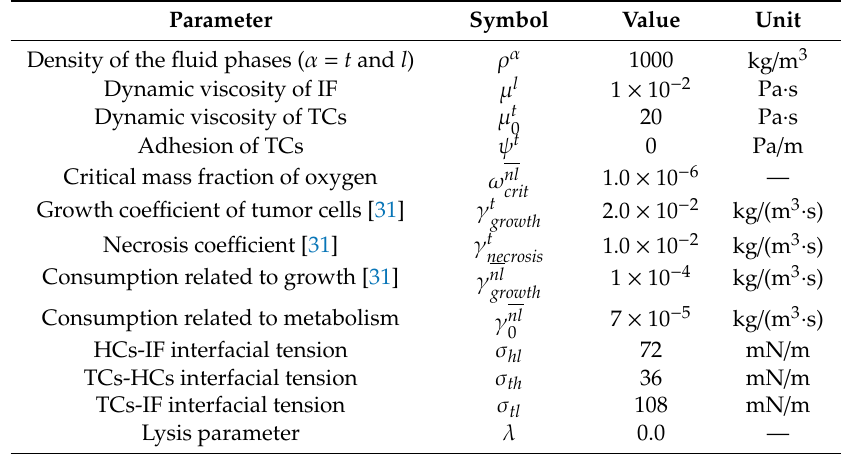
Table 1. Parameters depending on cells’ type and IF.